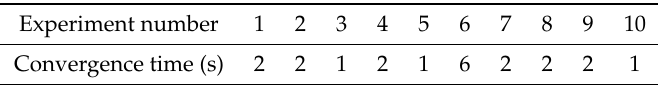
Table 3. Time to achieve global localization of UAPF.